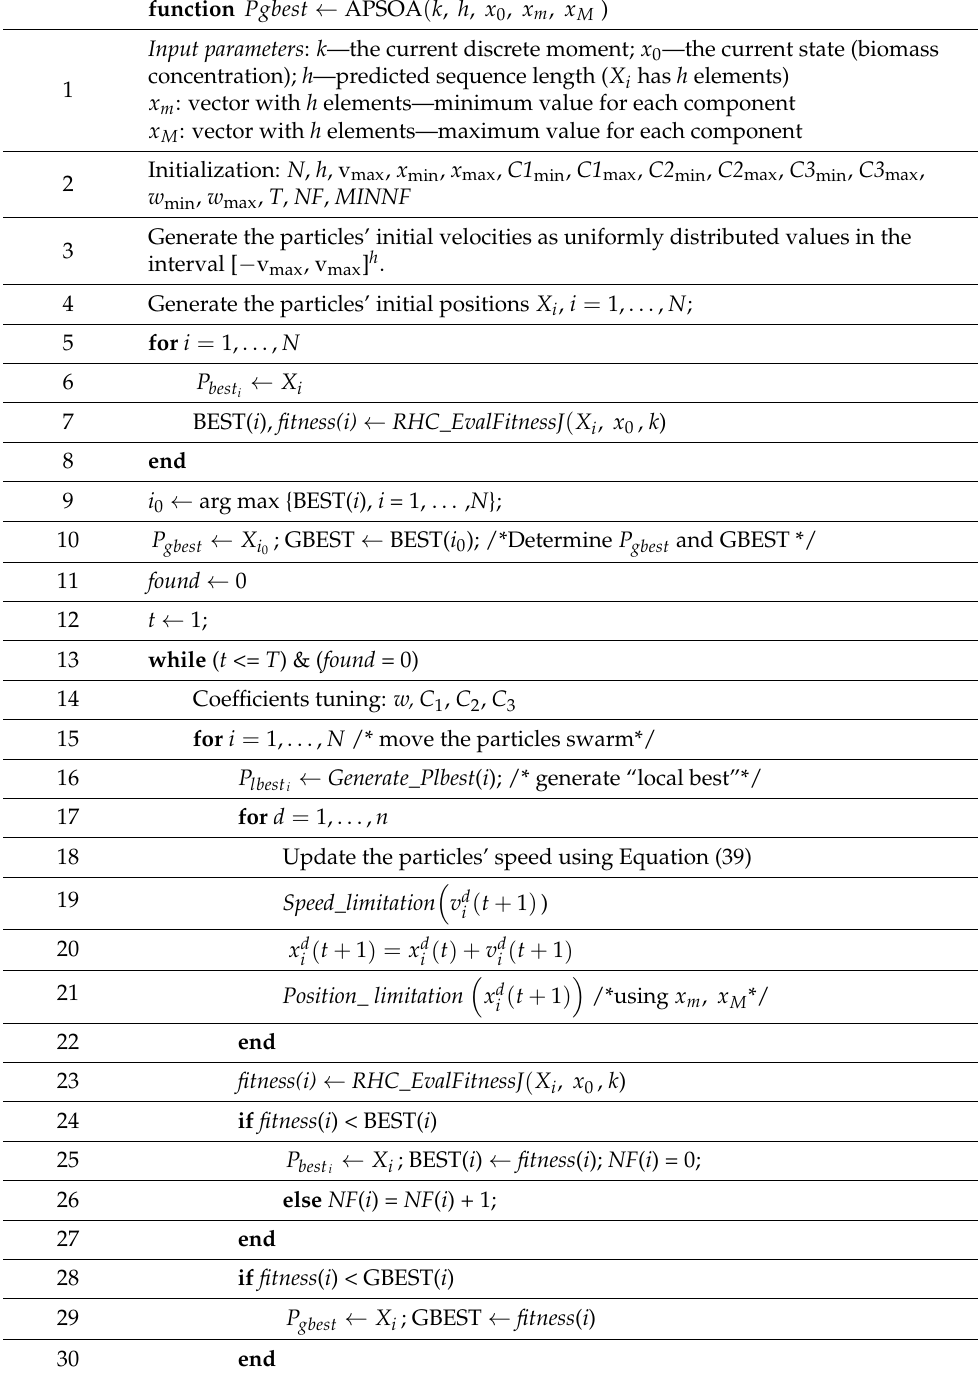
Table A1. Description of adaptive particle swarm optimization